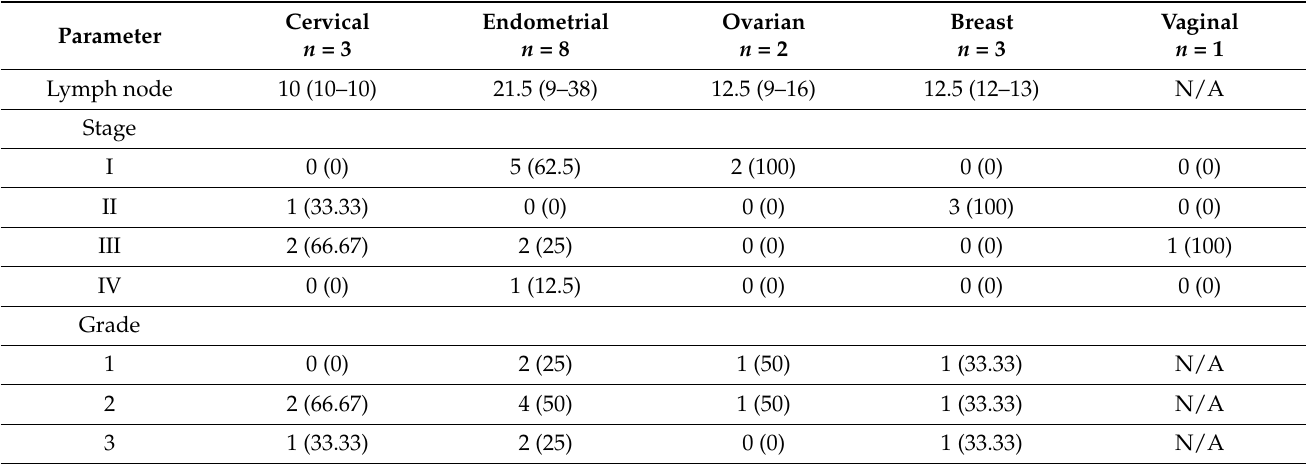
Table 3. Lymph node status and grading of the study